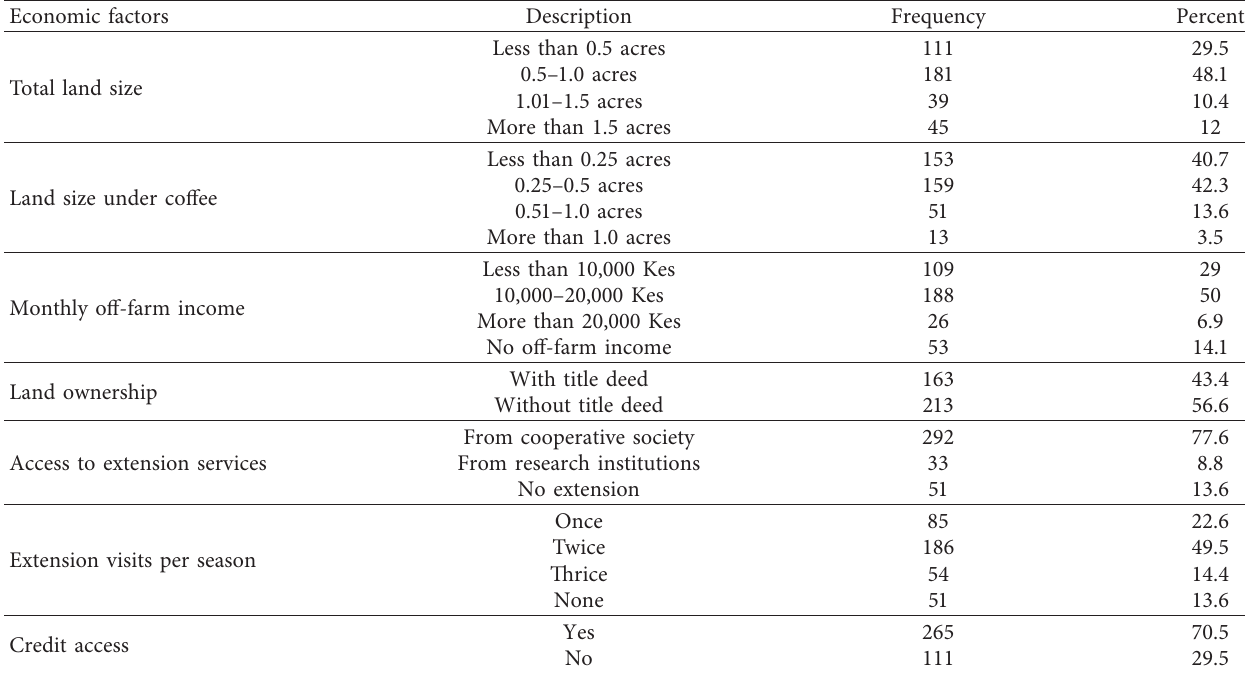
Table 2: Descriptive statistics of economic factors of the sampled